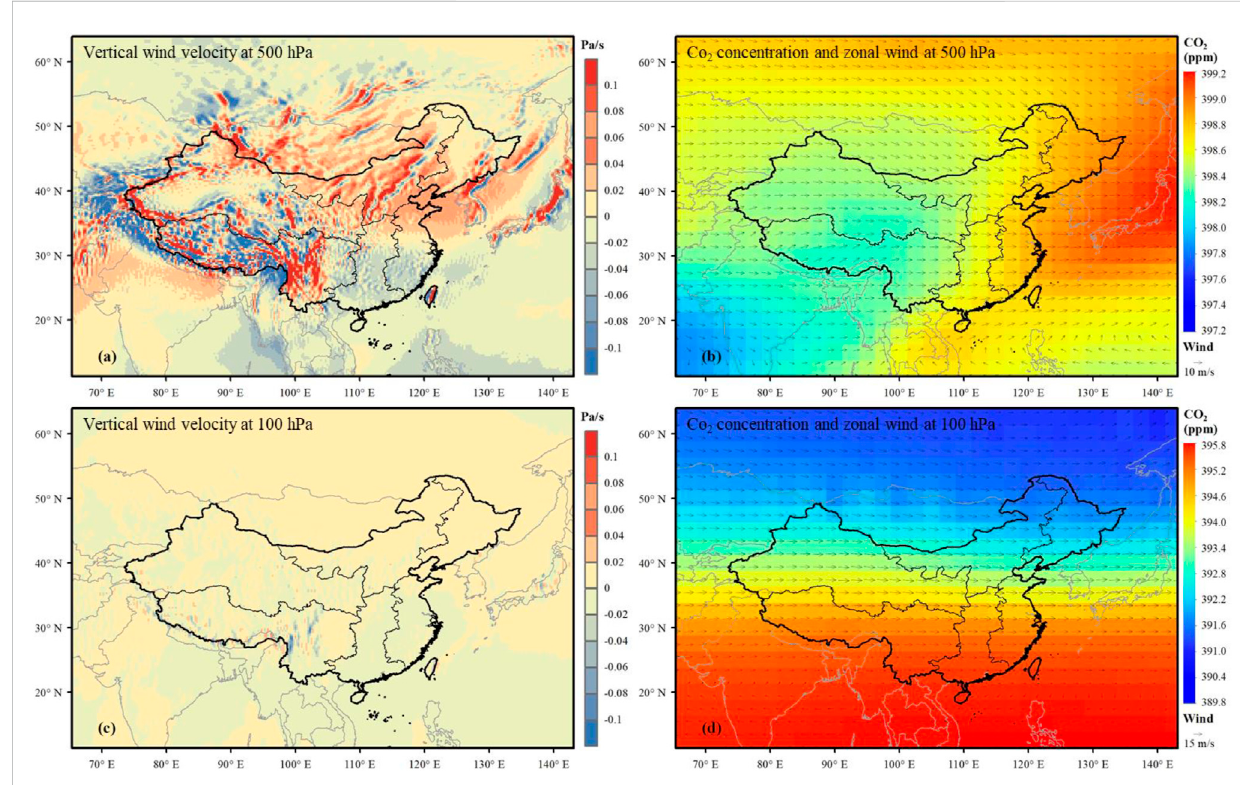
FIGURE 14 Multi-yearaverageclimatologyoftroposphericcirculationatthemiddle(500 hPa)andupper(100 hPa)troposphere,with (A,C) fortheverticalwind velocity, and (B, D) for the zonal wind and the annual mean CO 2